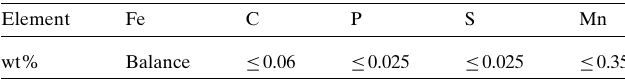
Table 1 Chemical composition of DX54 steel (Collins et al. , 2015).